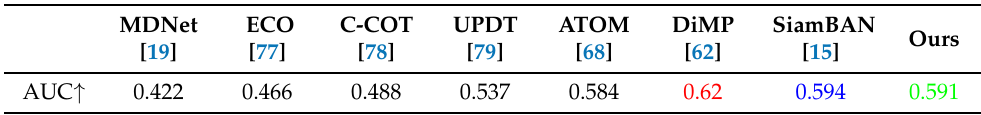
Table 6. AUC of comparison with state-of-the-art trackers on the NFS dataset in higher frame rate tracking scenarios.